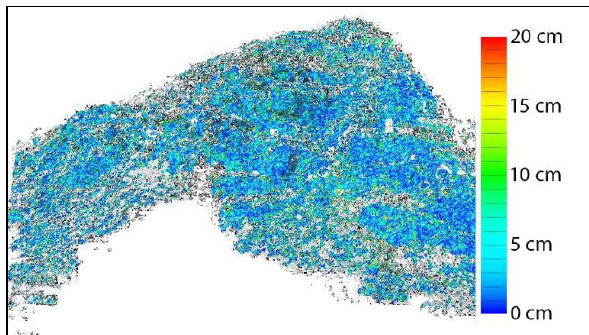
Figure 6: Repeatability between two 4-hours separated DSMs.